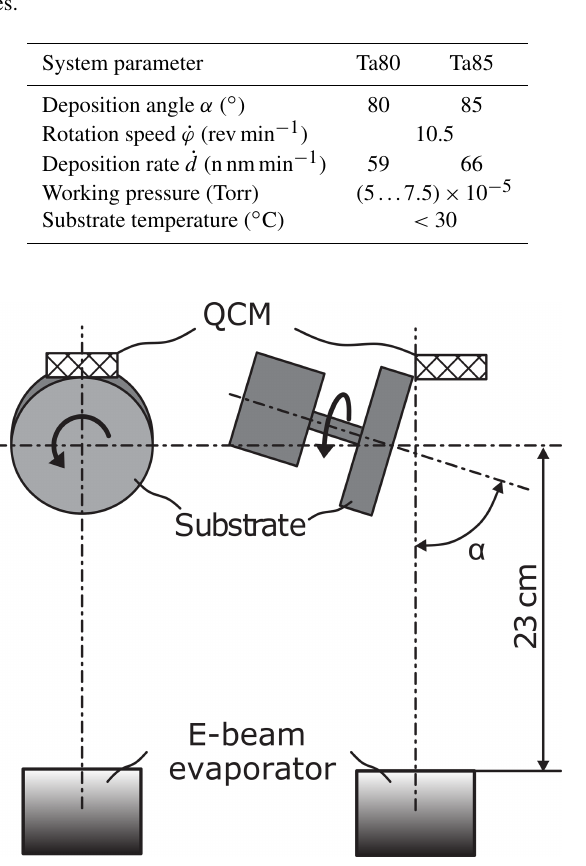
Table 1. Conditions for the deposition of the Ta80 and Ta85 sam- ples.